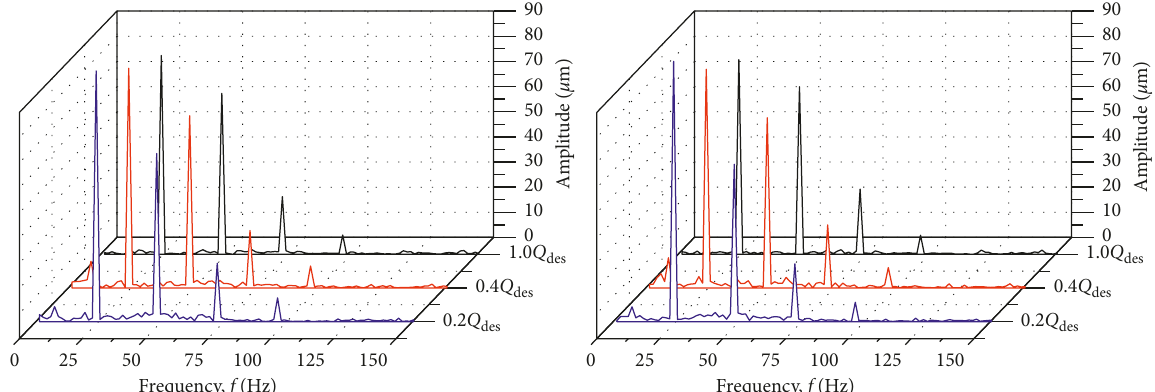
Figure 11: Frequency spectrogram of X and Y direction: (a) X direction. (b) Y